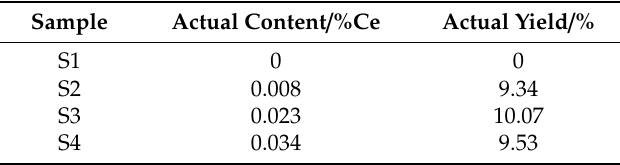
Table 2. Actual cerium contents and measured